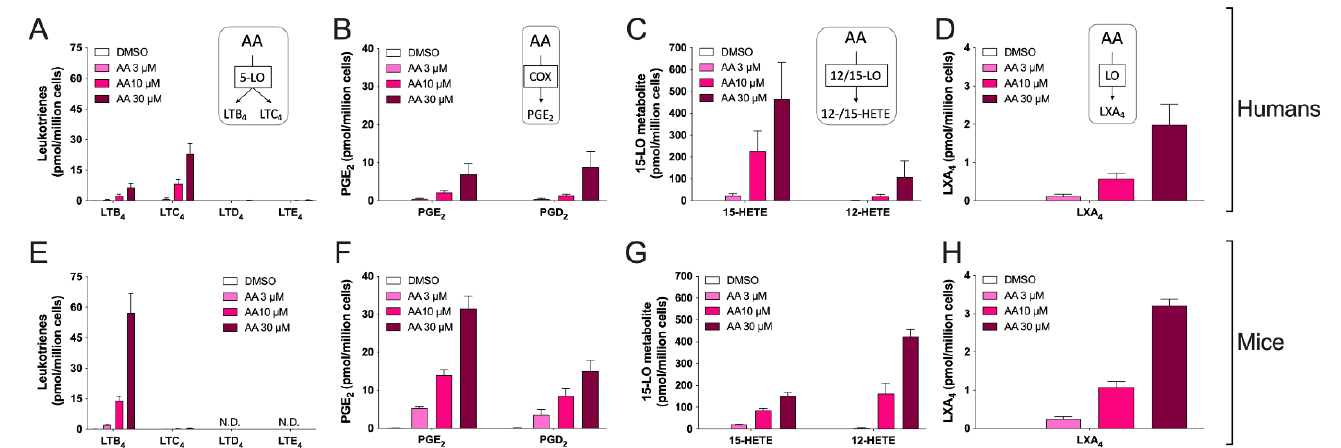
Figure 1. Biosynthesis of AA-derived eicosanoids from human and mouse eosinophils. EOS suspen- sions (5 × 10 6 cells/mL, 37 °C) were treated with DMSO or increasing concentrations of AA for 15 min. Incubations were stopped by adding one volume of cold (−20 °C) MeOH containing internal standards. Samples were then processed and analyzed for eicosanoids by LC-MS/MS, as described in Materials and Methods. ( A – D ) Results are the mean (± SEM) of 6 independent experiments using human eosinophils from asthmatic donors. ( E – H ) Results are the mean (± SEM) of 7 independent experiments using bone marrow-derived mouse eosinophils.